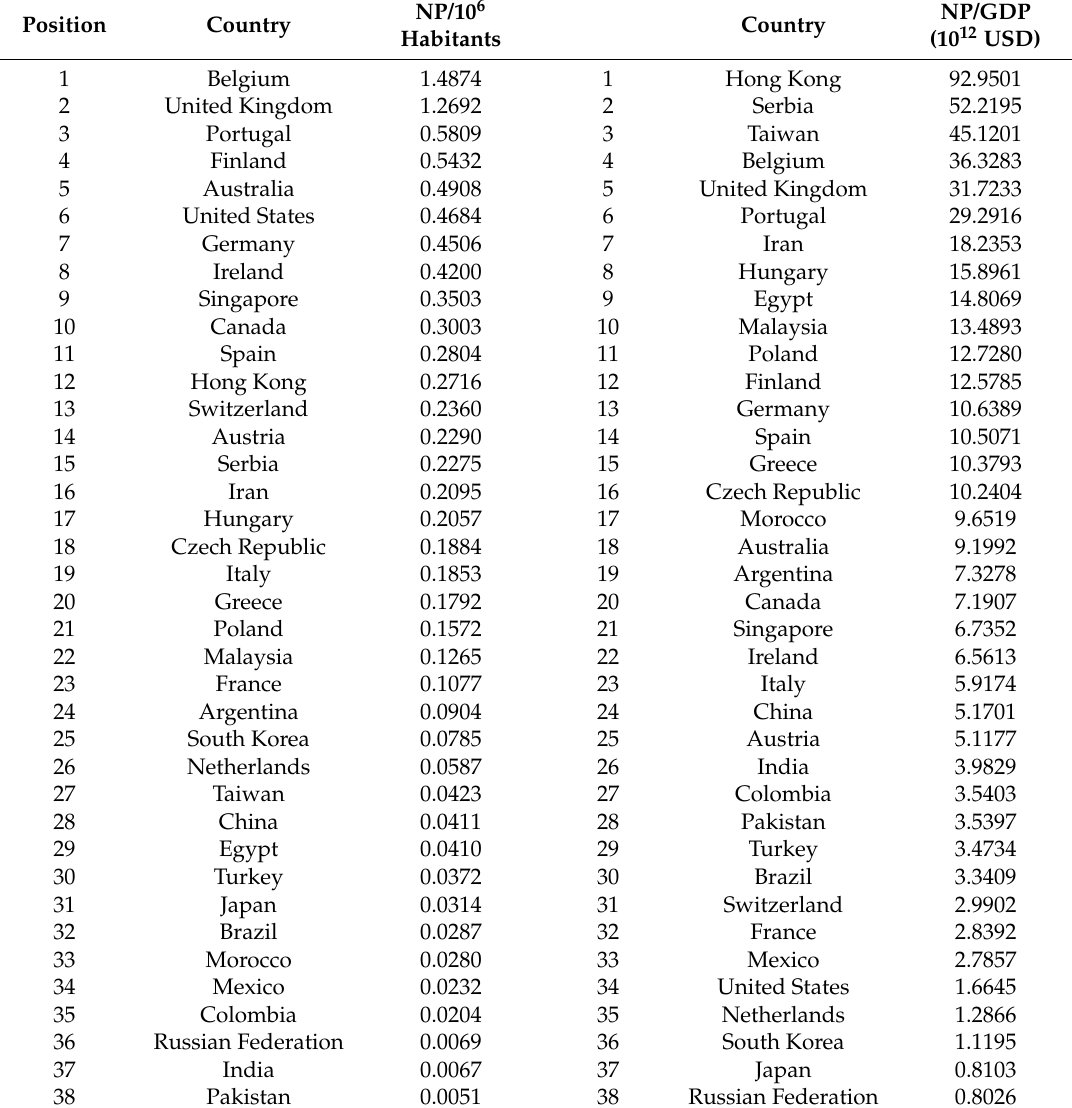
Table 8. Country positions after sorting out the data according to the ratios of ‘Number of publications/Million habitants (left); and the ‘Number of publications/GDP (GDP in 10 12 USD) (right).